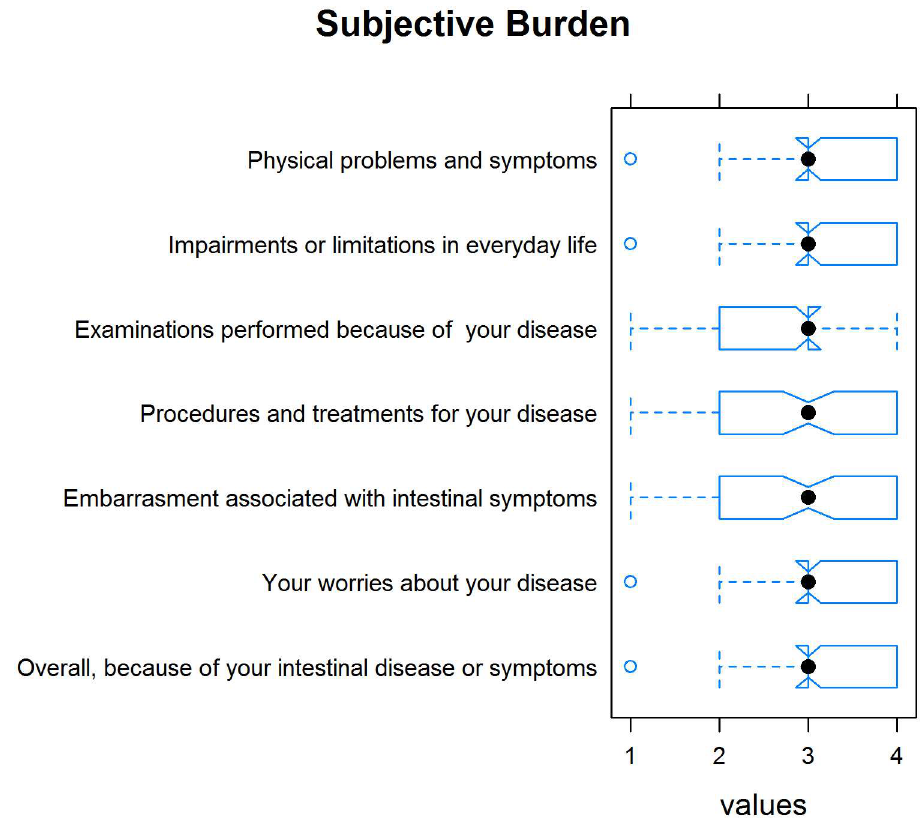
Fig 8. Tukey’s box plots with a notch depicting the subjective burden of various aspects of the disease and their